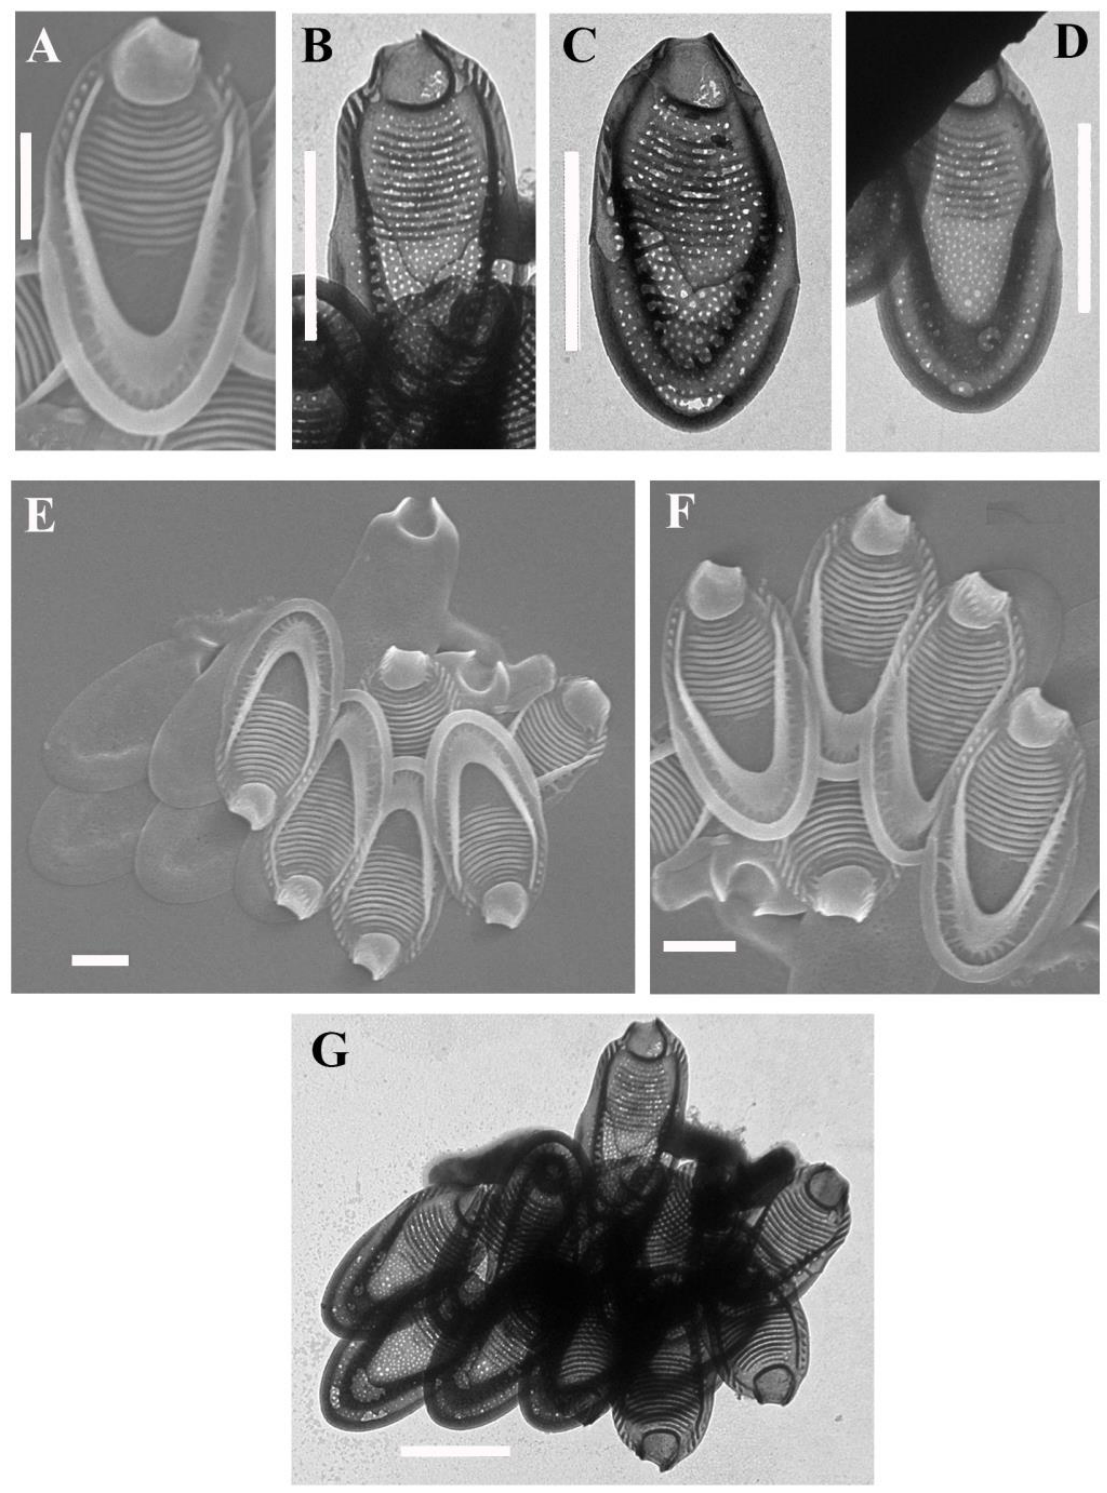
Figure 2. Mallomonas altaica sp. nov. ( A ) Body scale, SEM; ( B – D ) body scales, TEM; ( E ) group of scales, illustrating an upper surface and bottom surface view, SEM; ( F ) group of body scales at higher magnification, SEM; and ( G ) group of body scales, TEM. Scale bars: ( B – D , G ) : 2 μm; ( A , E , F ): 1 μm.